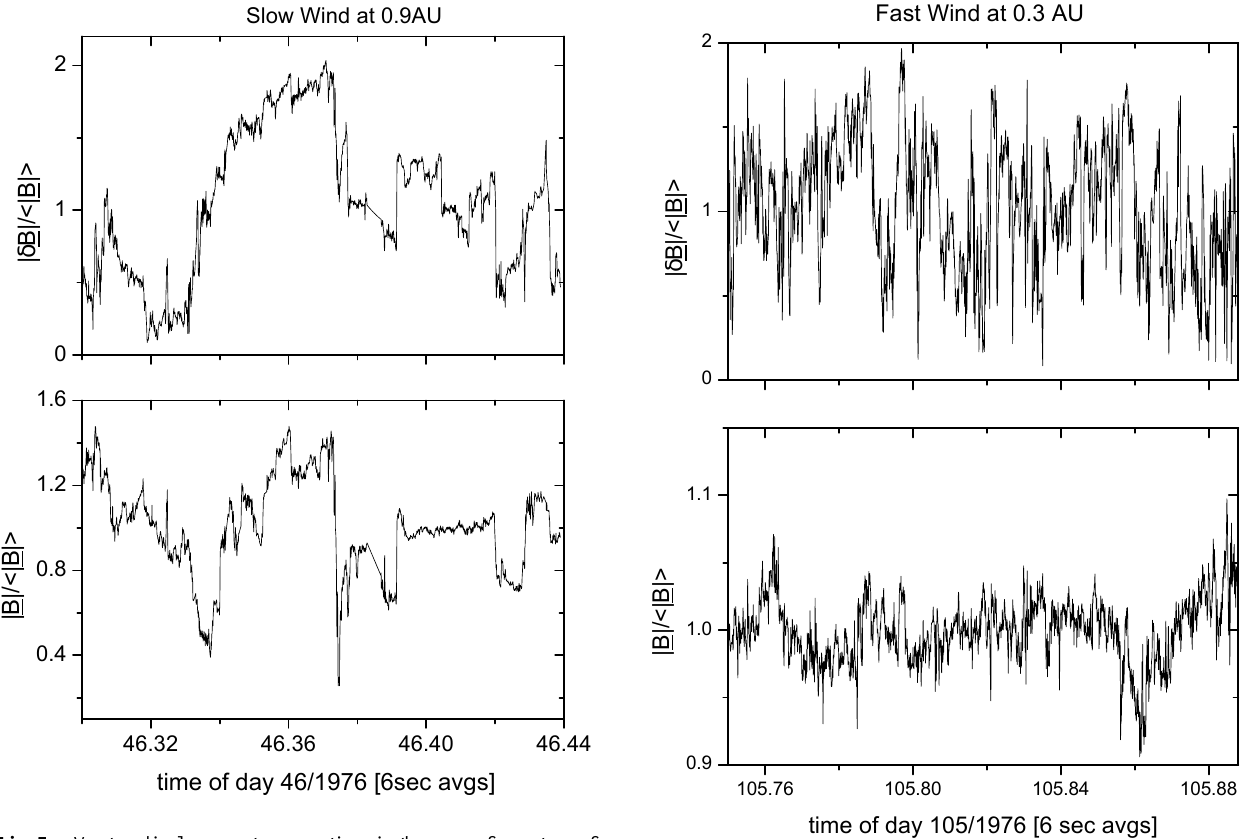
Fig. 5. Vector displacement versus time in the same format as of Fig. 4 relative to a slow wind at 0.9AU. Largest vector displace- Fig. 6. Fast wind at 0.3AU. Normalized vector displacements ver- ments (top panel) often coincide with large compressive events, as sus time in the same format as Figs. 4 and 5, shown in the top panel, shown in the bottom panel. As shown in the paper, the statistics of while normalized vector intensities are shown in the bottom panel. these vector displacements is remarkably similar to that shown in The top panel shows large fluctuations which are difficult to relate the previous Fig. 4 to the profile of the magnetic field intensity in the bottom panel, al- . though some corresponding events can still be recognized. In this sense, fast wind at 0.3AU differs from the slow wind samples we already